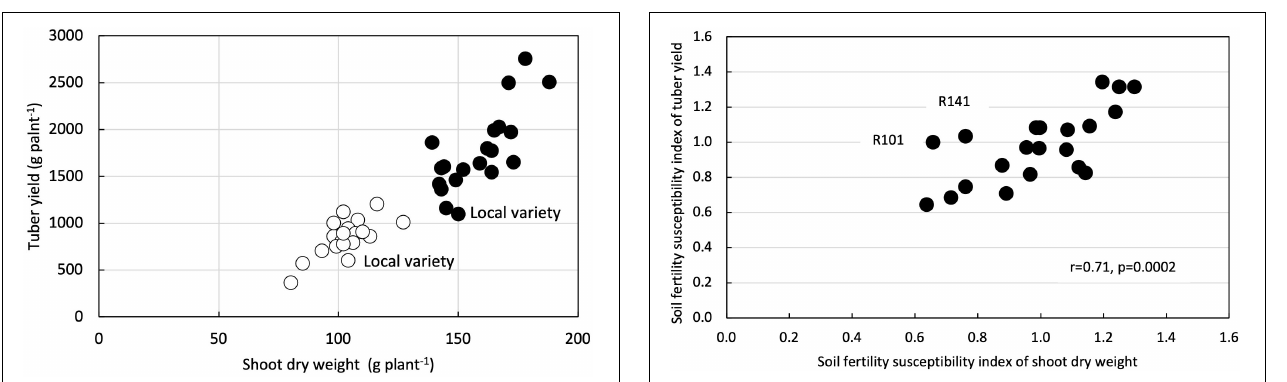
FIGURE 4 | Correlation between shoot dry weight and tuber yield under low nutrients soil fertility condition and high nutrient soil condition in 21 white Guinea yam genotypes.